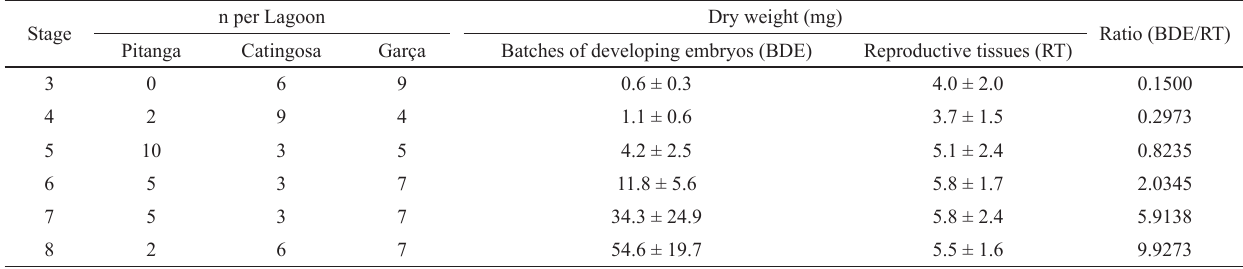
Table 2. Variation in dry weight of the batch of developing embryos (n) and reproductive tissues (mean ± S.D.) and their ratio across the developmental Stages 3 and 8 of the one-sided livebearer Jenynsia multidentata inhabiting coastal lagoons of the northern of Rio de Janeiro State,